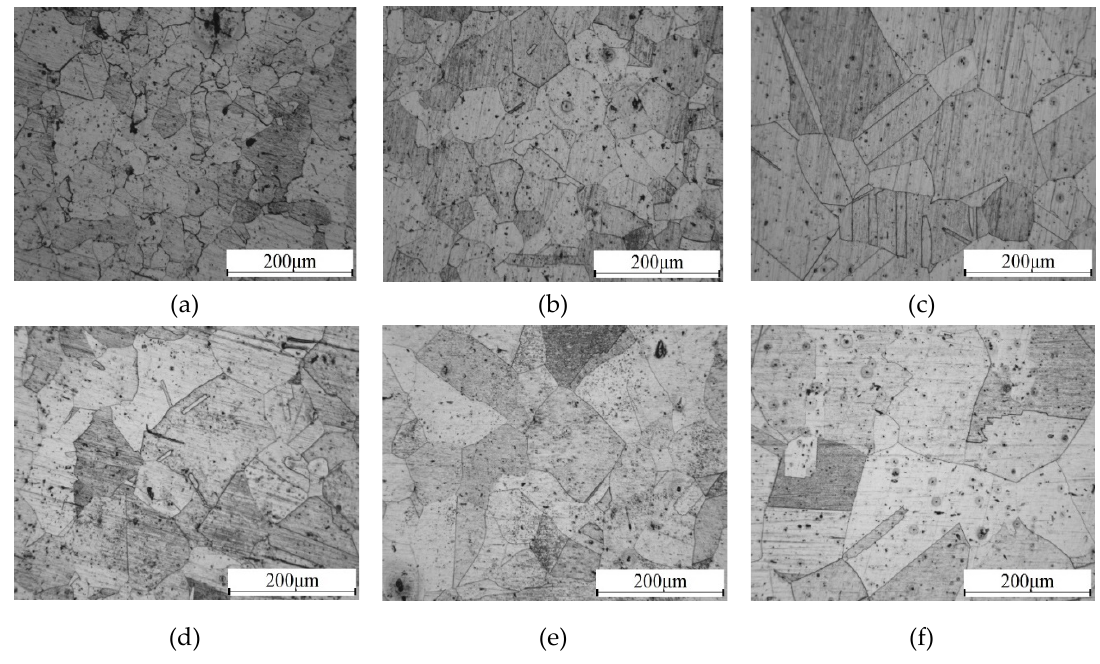
Figure 3. Microstructural evolution of TP304 stainless steel at six different stages: ( a ) raw material, ( b ) specimen after annealing for 2 h, ( c ) specimen after annealing for 4 h, ( d ) specimen after annealing for 6 h, ( e ) specimen after annealing for 10 h, and ( f ) specimen after annealing for 14 h.